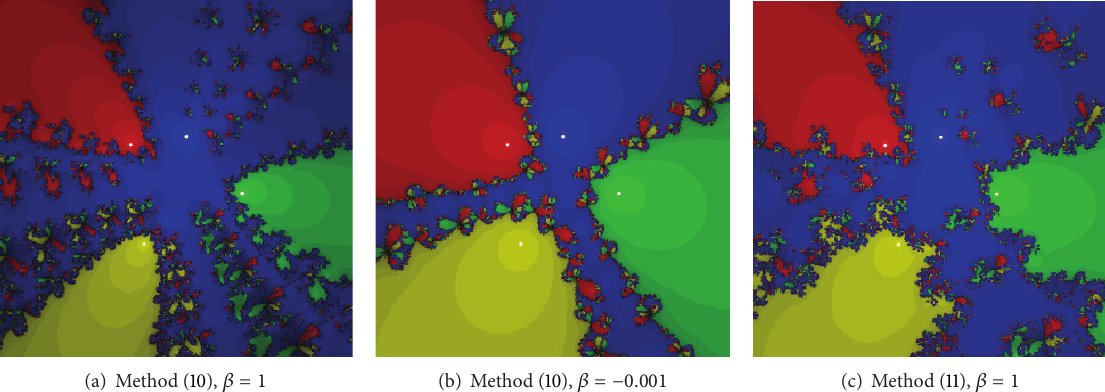
Figure 22: Basins of attraction for the test problem